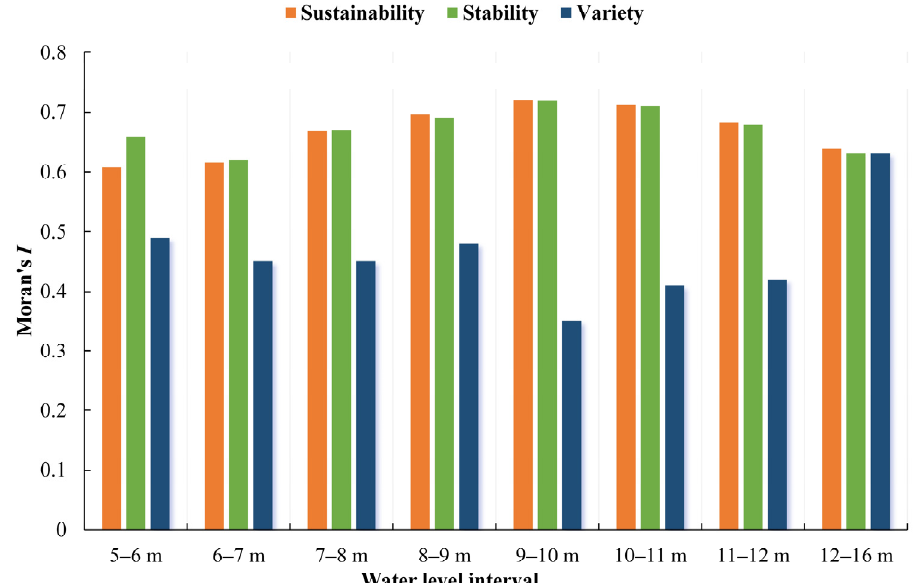
Figure 6. Global Moran’s I statistics of the vulnerability distributions of crane habitats within various water level intervals.